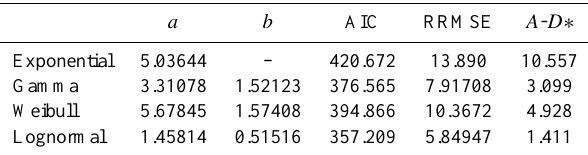
Table 2. Marginal distribution parameters and goodness of fit re- sults for average intensity ( I ).